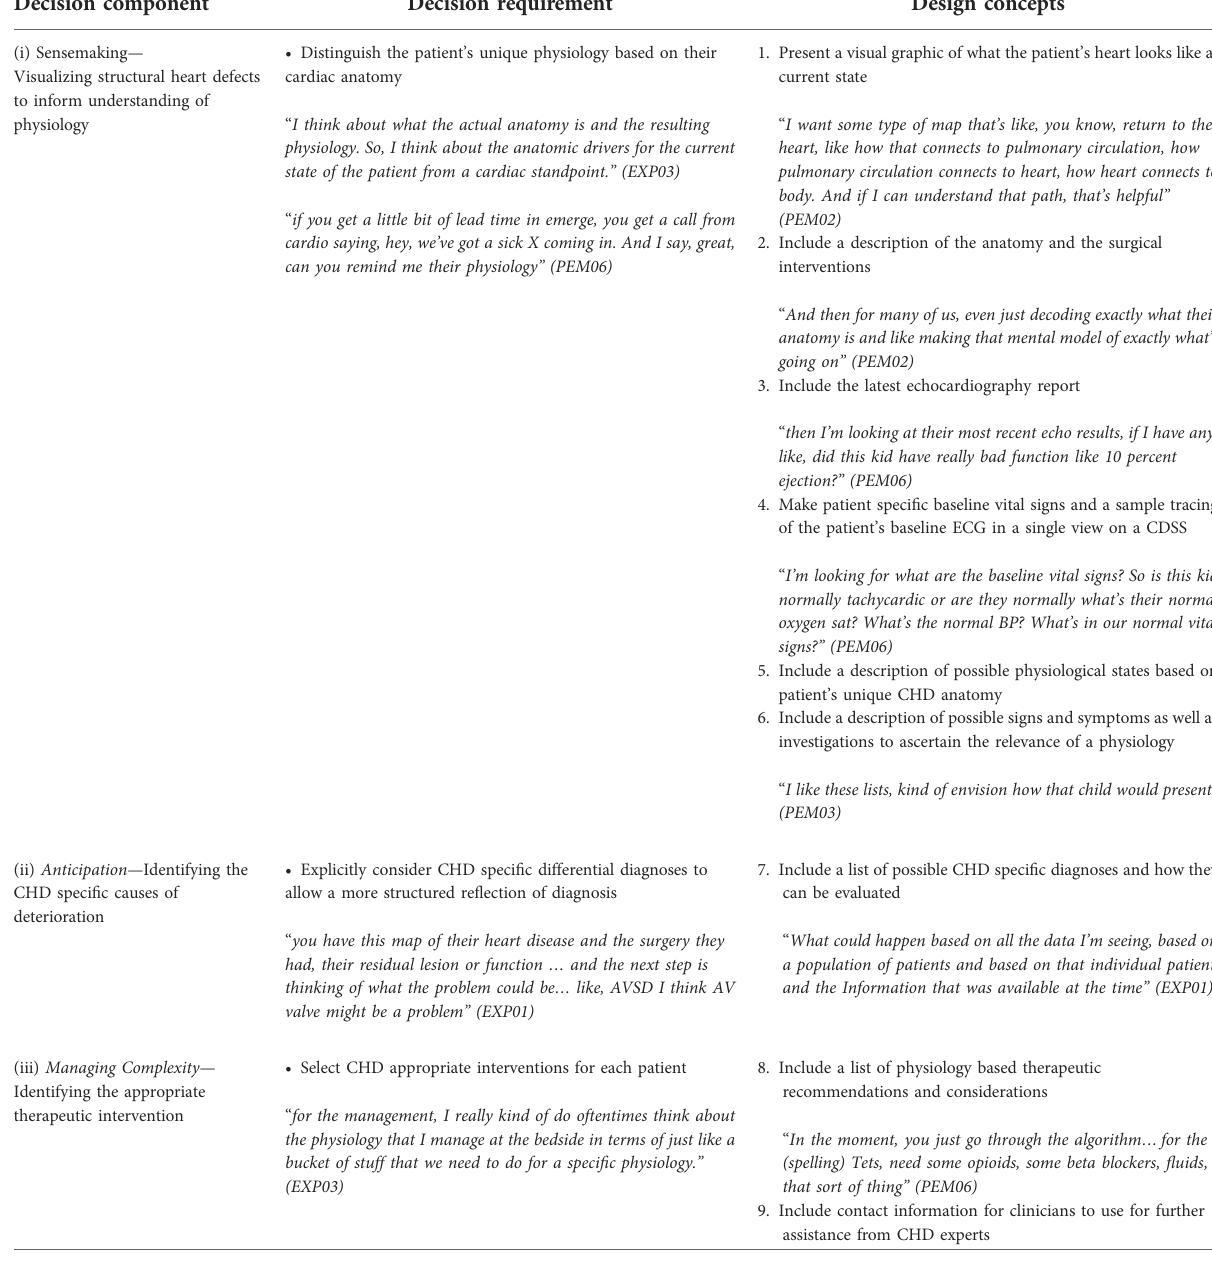
TABLE 2 Decision requirements and design concepts table to inform the design of MyHeartPass ™